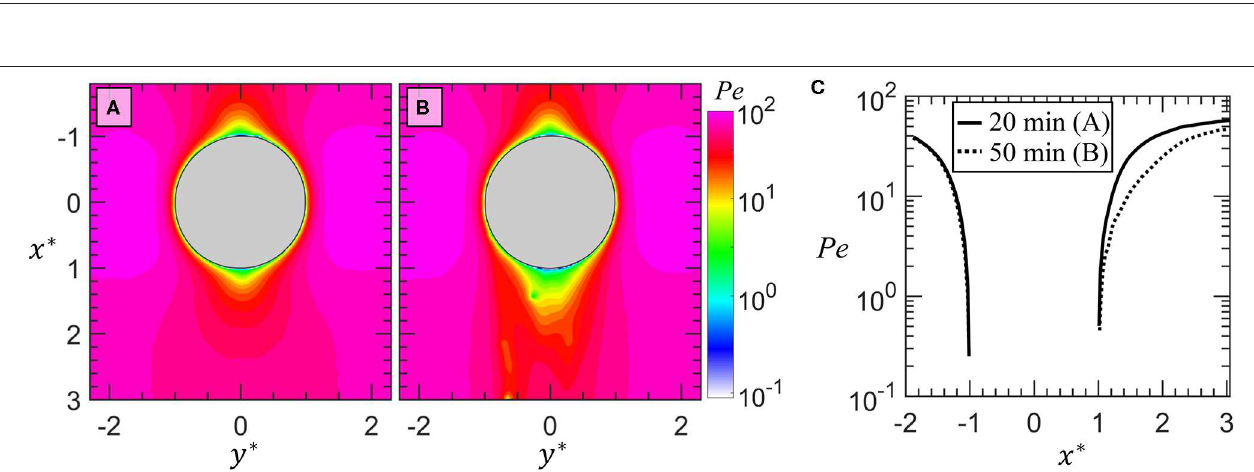
FIGURE 6 | In (A) , Peclet numbers are shown for the drop prior to attachment of bacteria at the same instance depicted in Figure 3 . In (B) , Peclet numbers are shown for the same drop after bacterial streams have developed on the trailing half of the drop at the same instance depicted in Figure 5 . The color contours are on a log scale with magnitudes corresponding to the color bar. In (C) a semilog plot of the Peclet numbers along y * without attached bacteria ( A at 20min) and with streamers ( B at 50min).